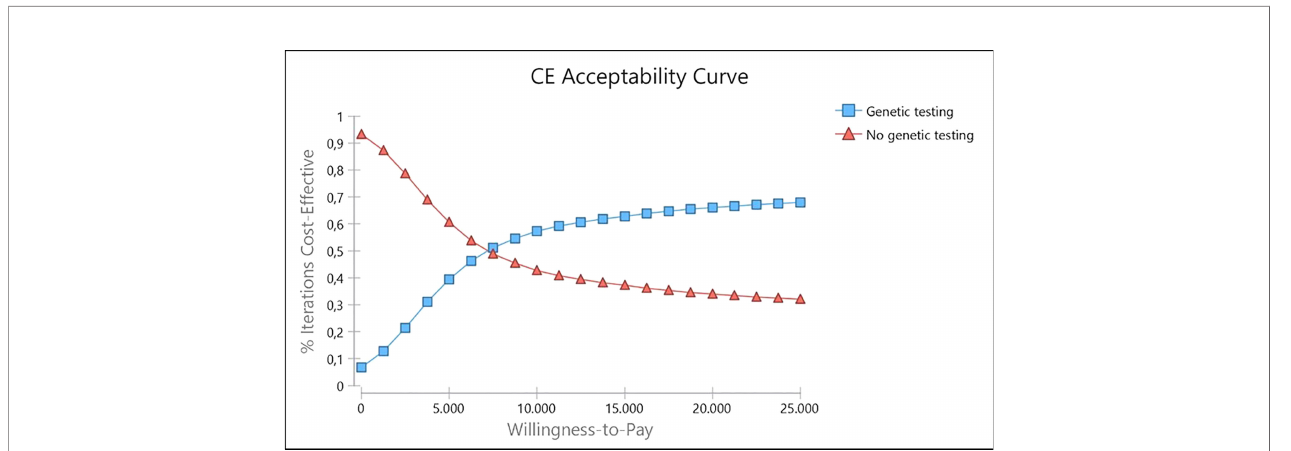
FIGURE 5 | Cost-effectiveness acceptability curve for genetic testing strategy provided to Brazilian